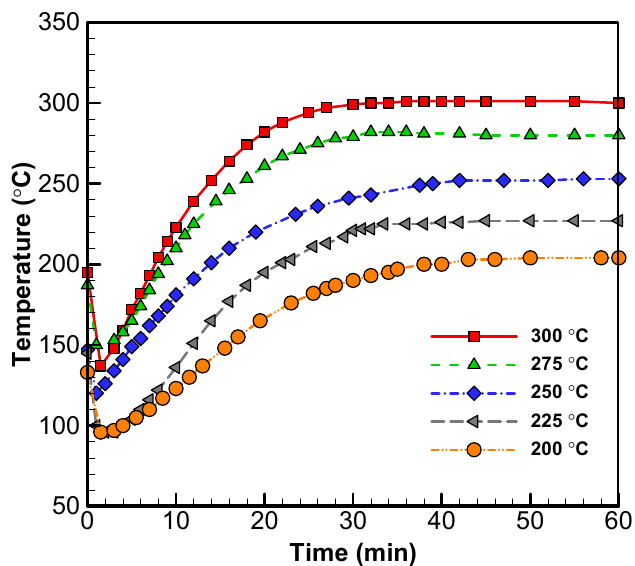
Figure A1. Temperature vs. time plots for the center sample in reactor trials (vacuum and nitrogen systems) for wood sawdust.